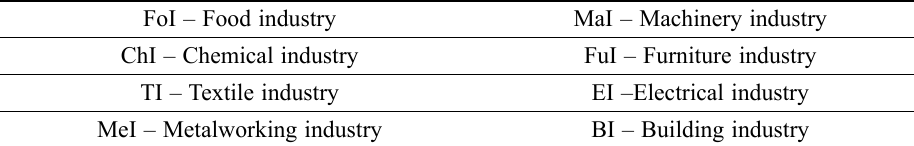
Table 2. The industrial branches of the monitored enterprises